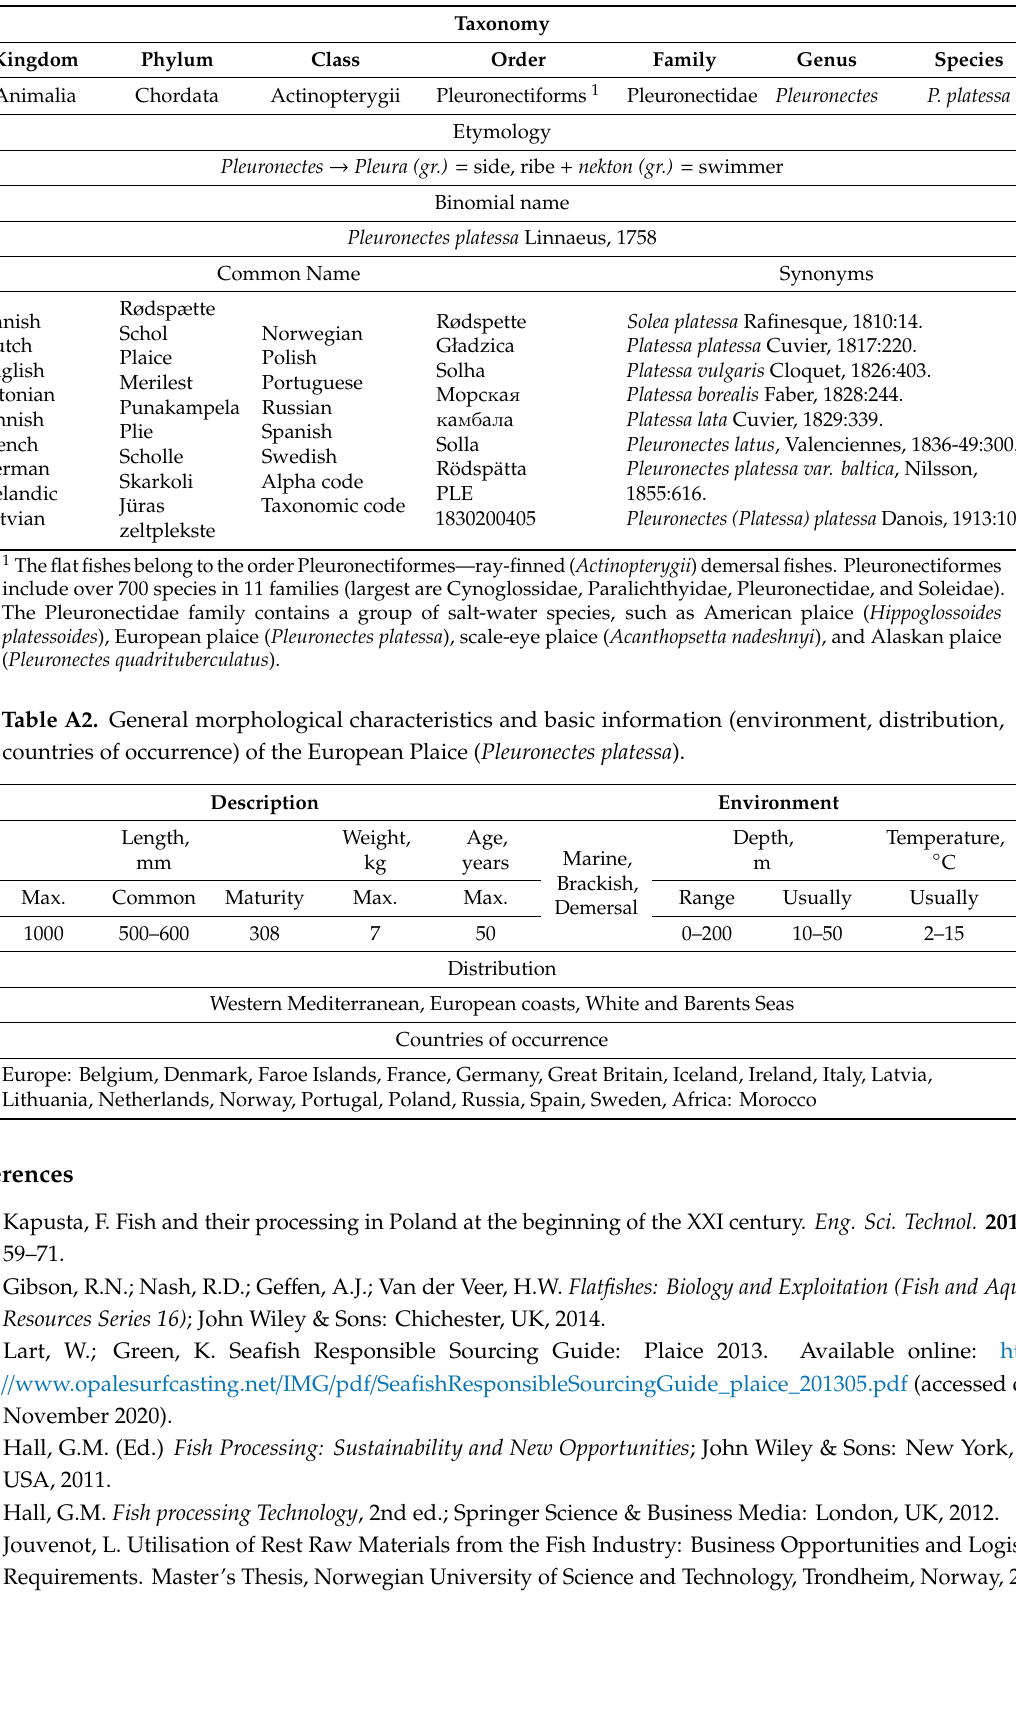
Table A1. Basic systematic information of the European plaice ( Pleuronectes platessa ).